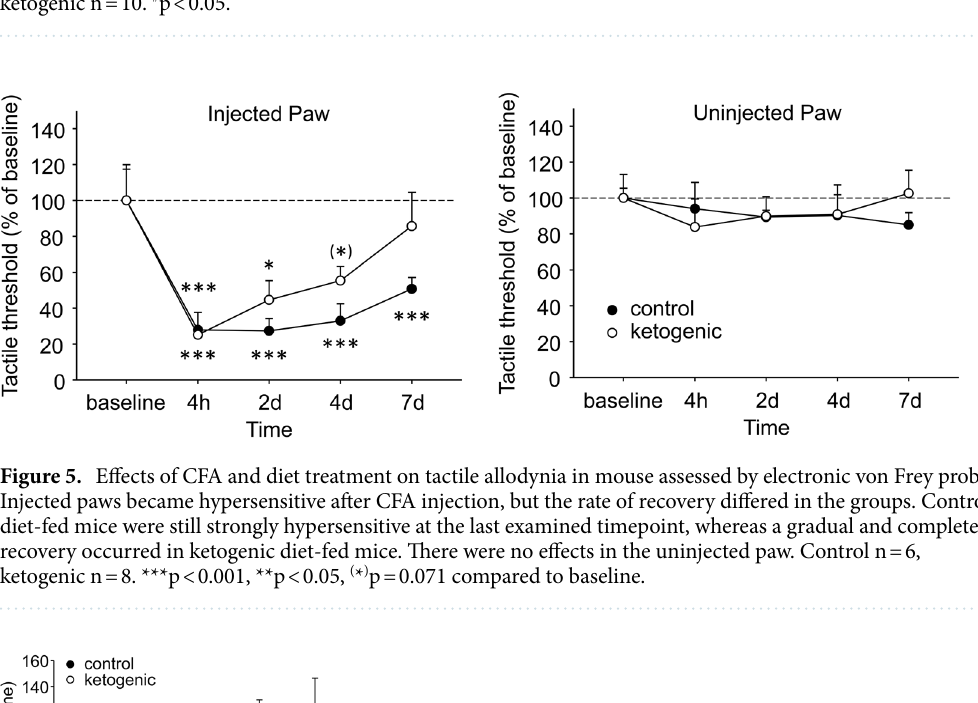
Figure 4. Effects of dietary treatment on CFA-induced inflammatory paw swelling in rats. Paw volume was expressed as the difference between volume at 50 h after CFA injection and volume at baseline. There was significantly less swelling in rats fed the ketogenic diet. There was no effect in control paws. Control n = 14, ketogenic n = 10. # p < 0.05.